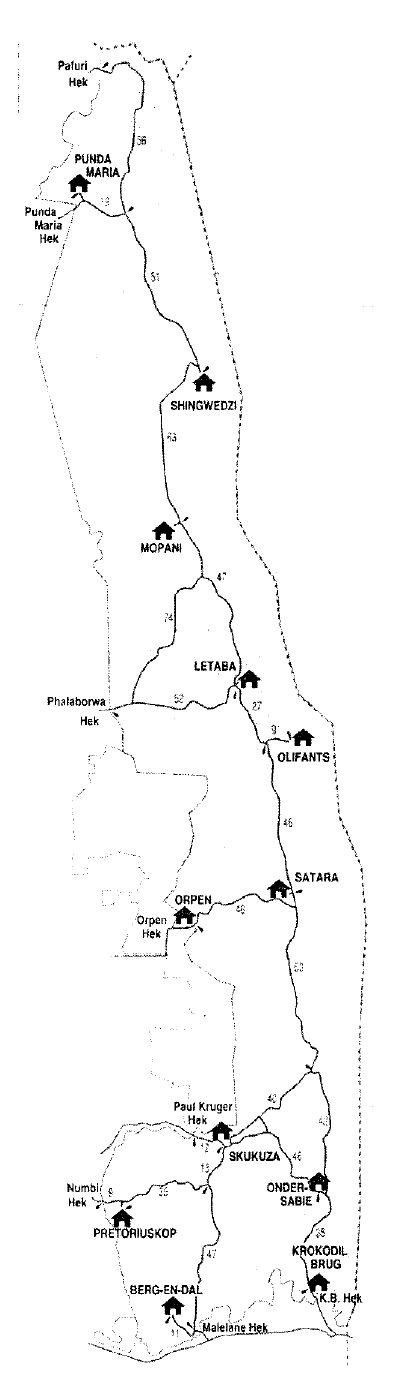
Fig. 1. Map of the Kruger National